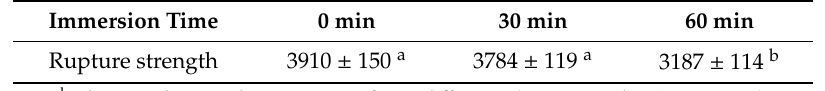
Figure 4. Energy-dispersive X-ray spectrometer (EDS) spectra and mapping results for sodium ions in CAG beads prepared at 5 °C after immersion in distilled water for different lengths of time. Table 6. Rupture strength of CAG beads generated at 5 °C after immersion in distilled water for different periods.